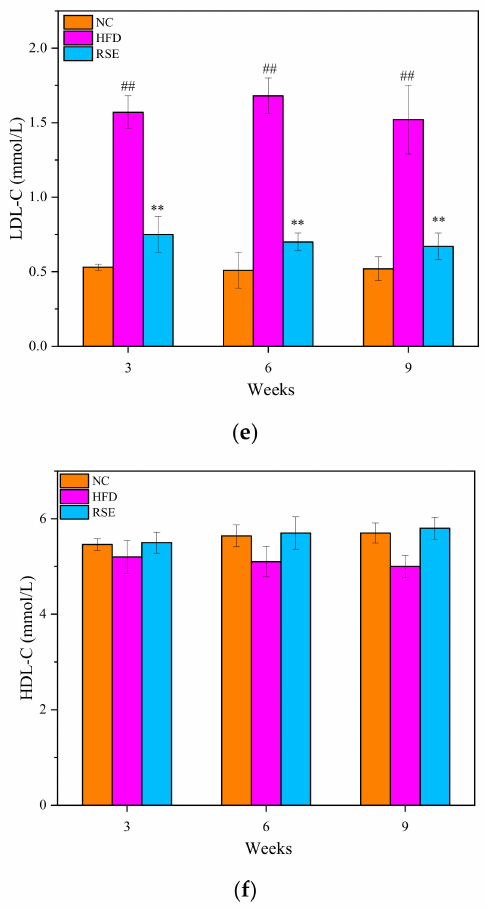
Figure 2. RSE prevented high-fat-diet-induced obesity. ( a ) Mean energy intake per mouse per day. ( b ) Body weight changes during 9-week intervention. ( c ) Serum total cholesterol (TC) level. ( d ) Serum triglyceride (TG) level. ( e ) Serum low-density lipoprotein cholesterol (LDL-C) level. ( f ) Serum high- density lipoprotein cholesterol (HDL-C) level. Data are expressed as the mean ± SEM. # p < 0.05 and ## p < 0.01 for NC vs. HFD; * p < 0.05 and ** p < 0.01 for RSE vs. HFD. NC, the normal chow group; HFD, the high-fat-diet group; RSE, the RSE treatment group. Table 2. Epididymal fat index during the intervention periods. Group 3